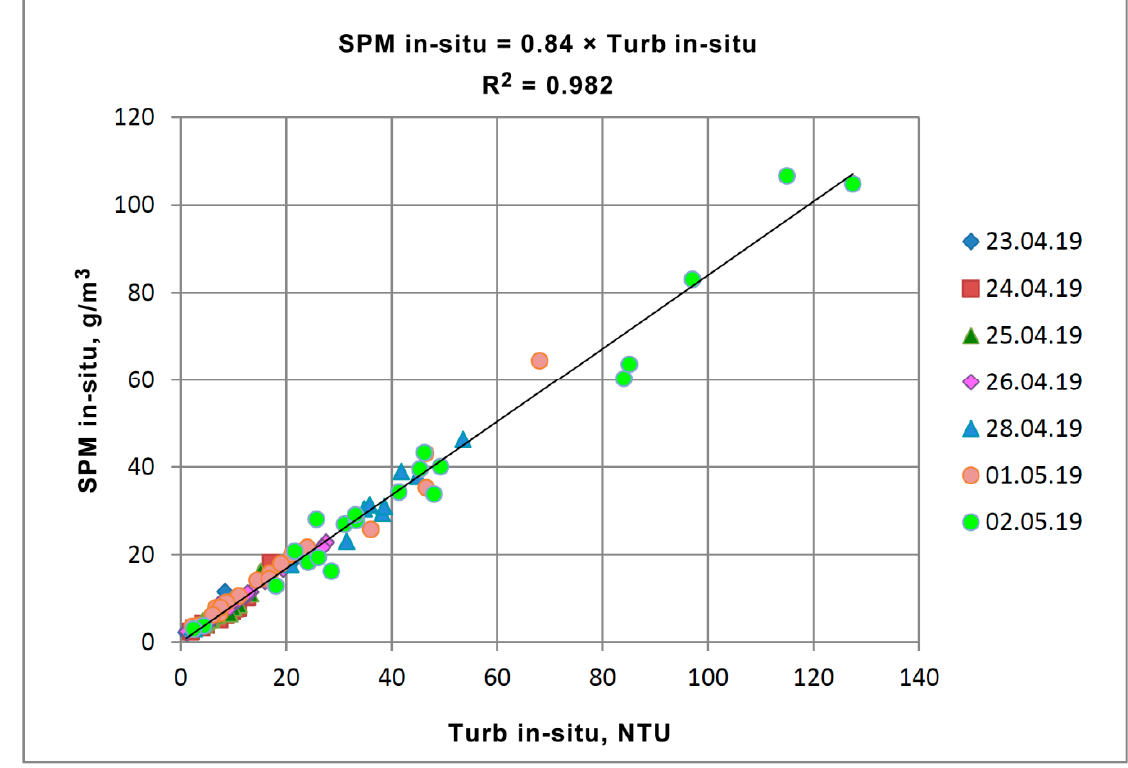
Figure 7. Comparison of SPM in the water samples (SPM in situ) and turbidity determined with PT (Turb in situ) for all measurement days in April–May 2020.